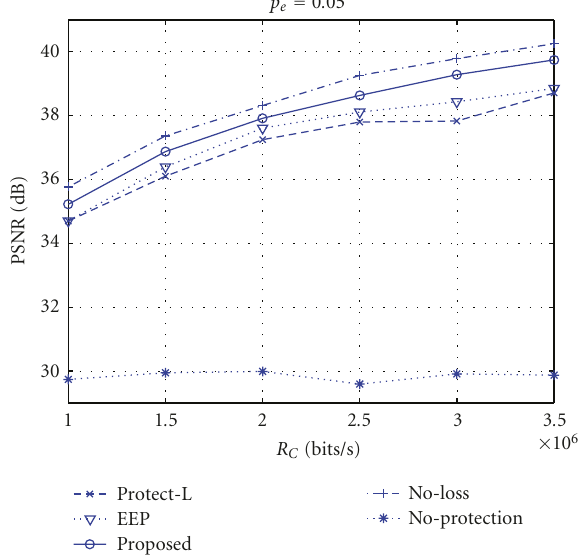
Figure 25: Results for p e = 0 . 20 for “Soccer”